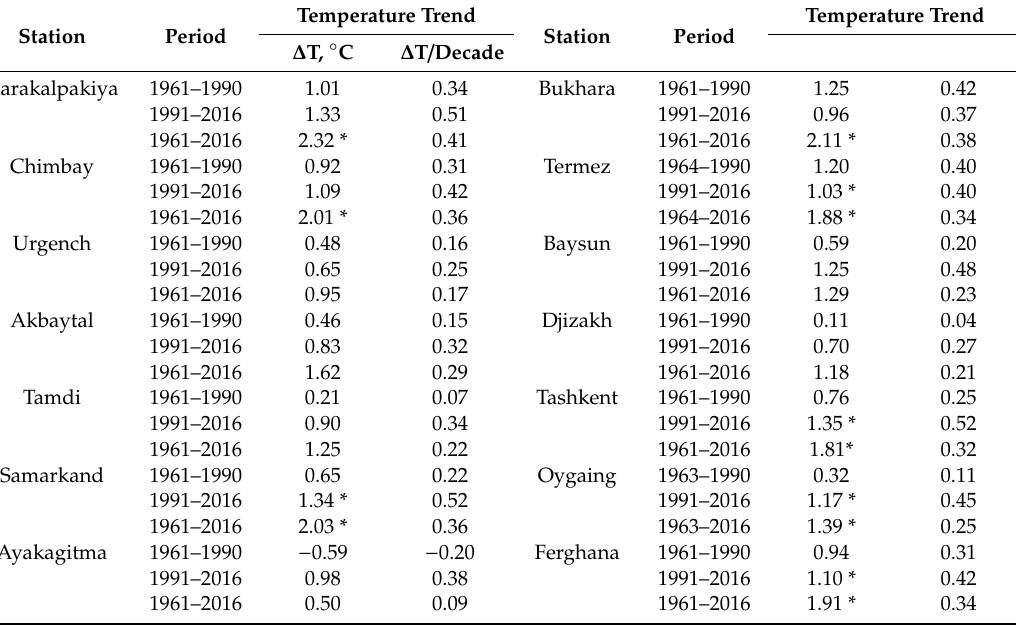
Table A3. Characteristics of mean annual temperature change at the representative stations in Uzbekistan.